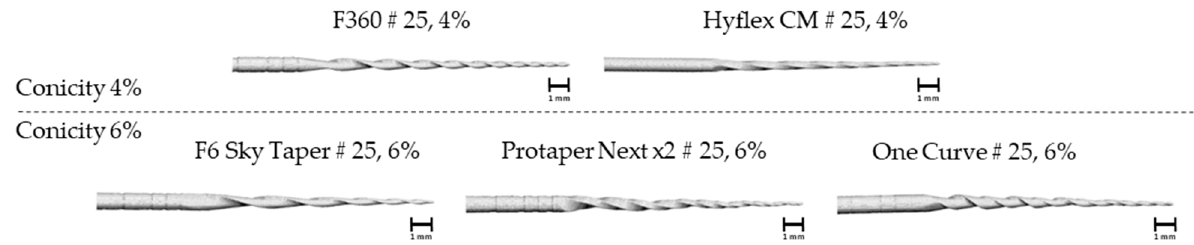
Figure 1. Stereolithography model (STL) files obtained with MicroCT of analyzed instruments. F360 and F6 Sky Taper are made of conventional NiTi alloy. Hyflex CM, Protaper Next and One Curve are constituted of heat treated NiTi alloys.